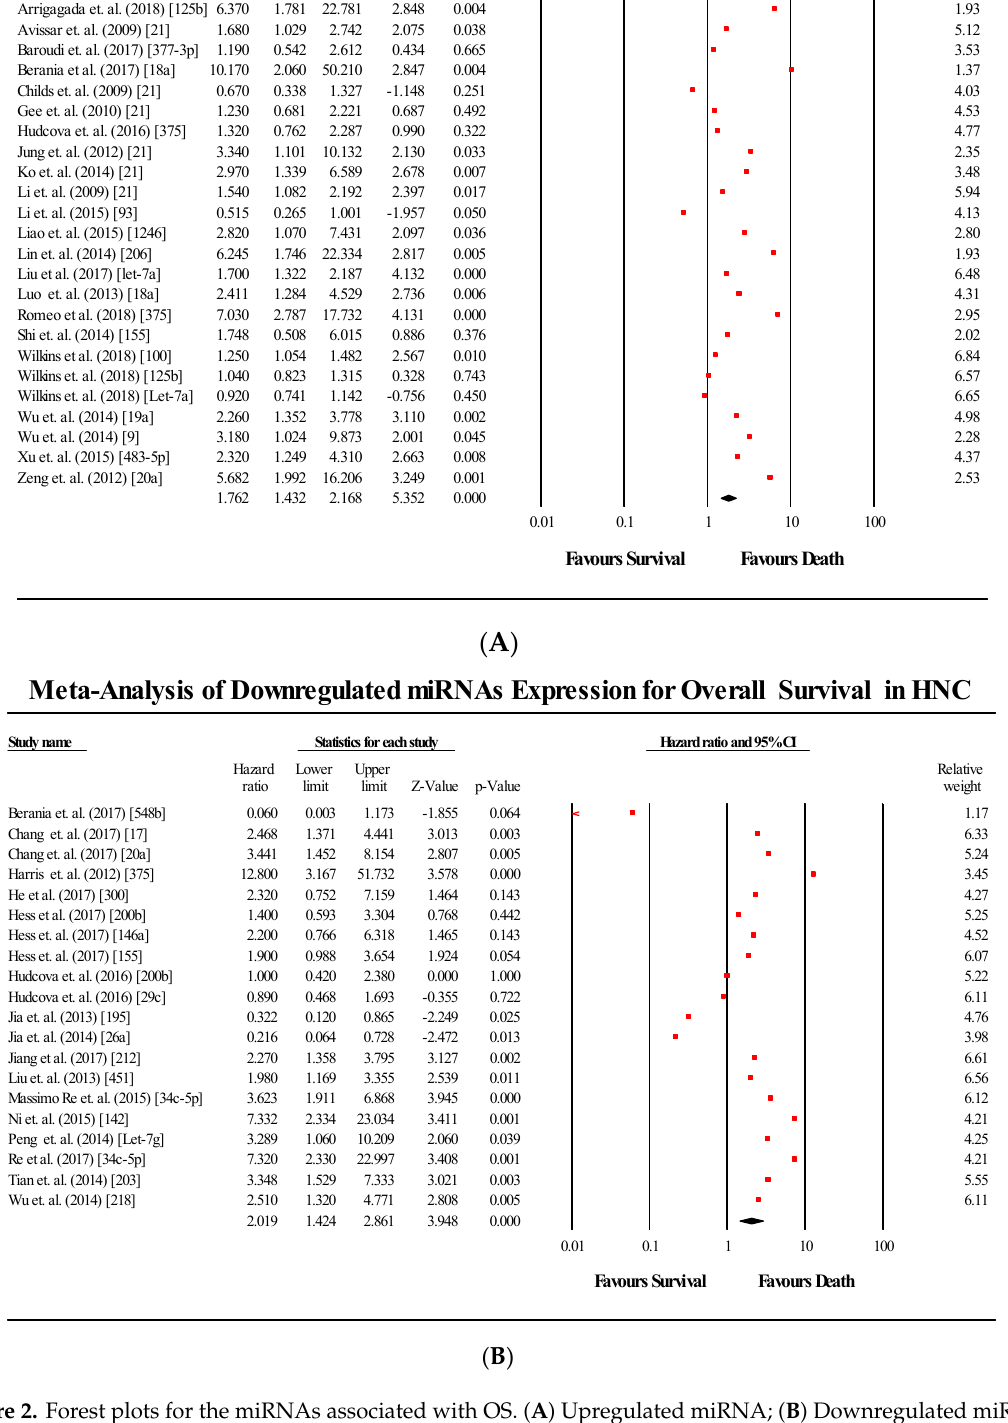
Figure 3. Forest plot for the miRNAs associated with DFS. 3.4. Subgroup Analysis 3.4.1. Upregulation and Downregulation Subgroups Subgroups were formed based on whether the miRNAs assessed in each study was found to be upregulated or downregulated compared to controls. The subgroups for upregulated and downregulated miRNA were assessed separately for OS and DFS. For OS, the upregulated miRNA cohorts ( n = 25) showed a pooled effect estimate (HR) of 1.762 (95% CI 1.432–2.168; p < 0.05), while the downregulated miRNA ( n = 20) cohorts showed a pooled effect